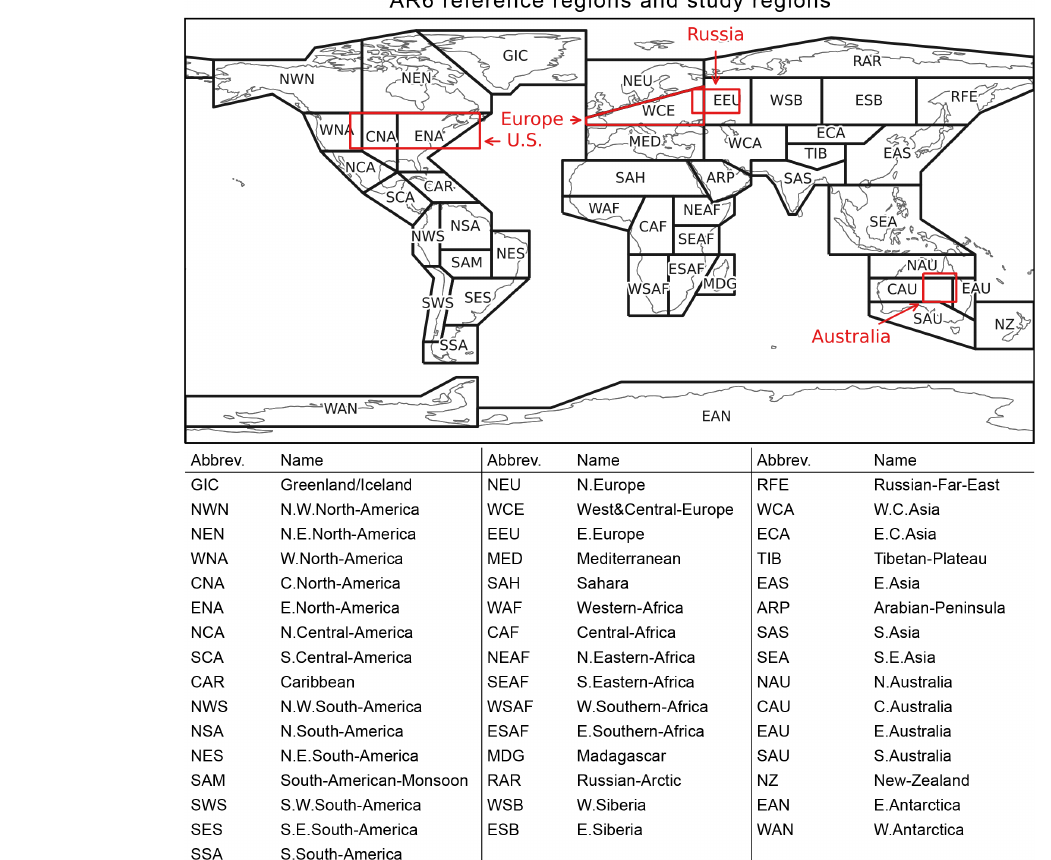
Earth Syst. Dynam., 13, 1167–1196,